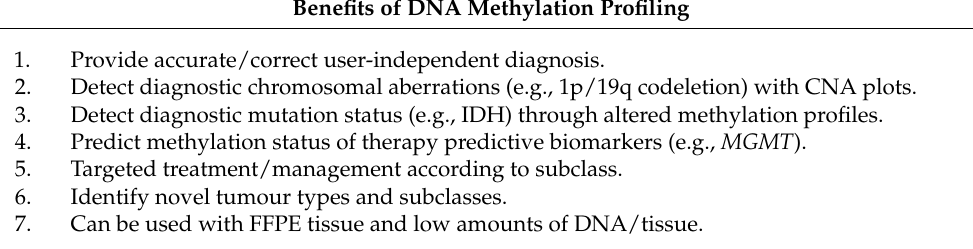
Table 2. A summary of the benefits of methylation-based classification in diffuse gliomas. FFPE— formalin-fixed